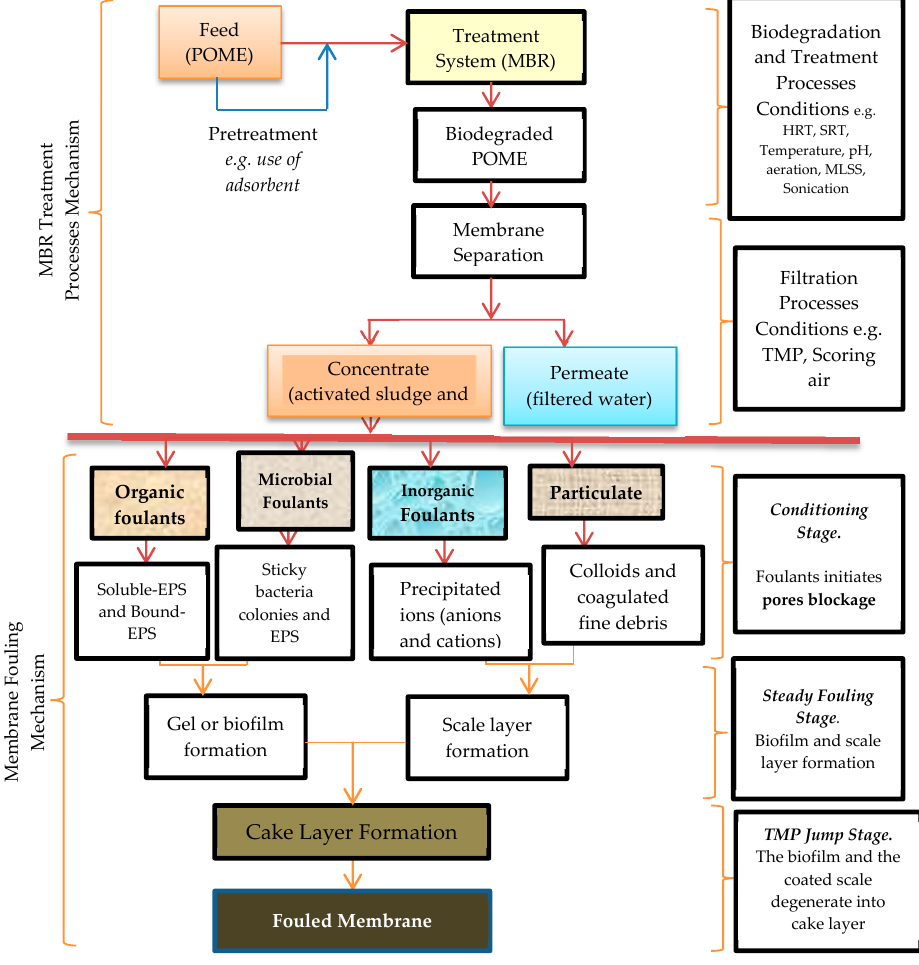
Figure 7. Flowchart showing MBR treatment process and membrane fouling mechanism.